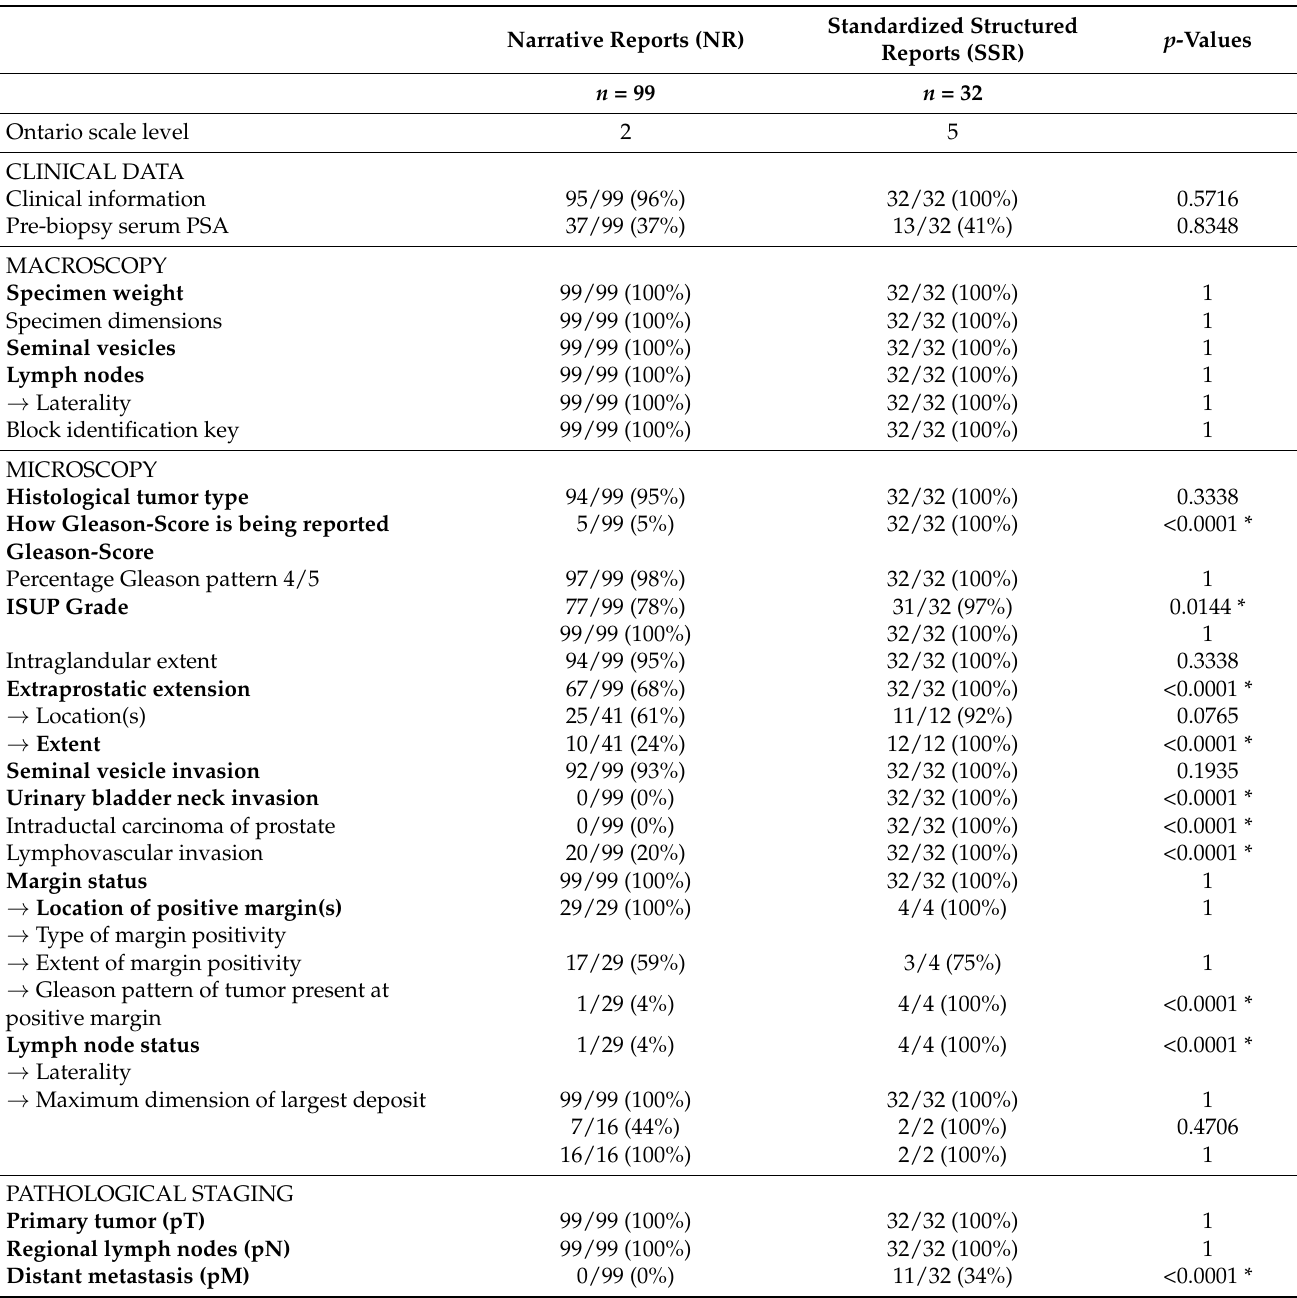
Table 3. Summary of all investigated categories and subcategories (17 considered as mandatory, high- lighted in bold) in narrative (NR) and standardized structured reports (SSR) of radical prostatectomy specimens according to recommendations by the International Collaboration on Cancer Reporting (ICCR), slightly adapted. The two-sided Fisher’s exact test was performed to compare categories in NR with SSR. p -values < 0.05 were considered statistically significant and are marked with an asterix. Narrative Reports